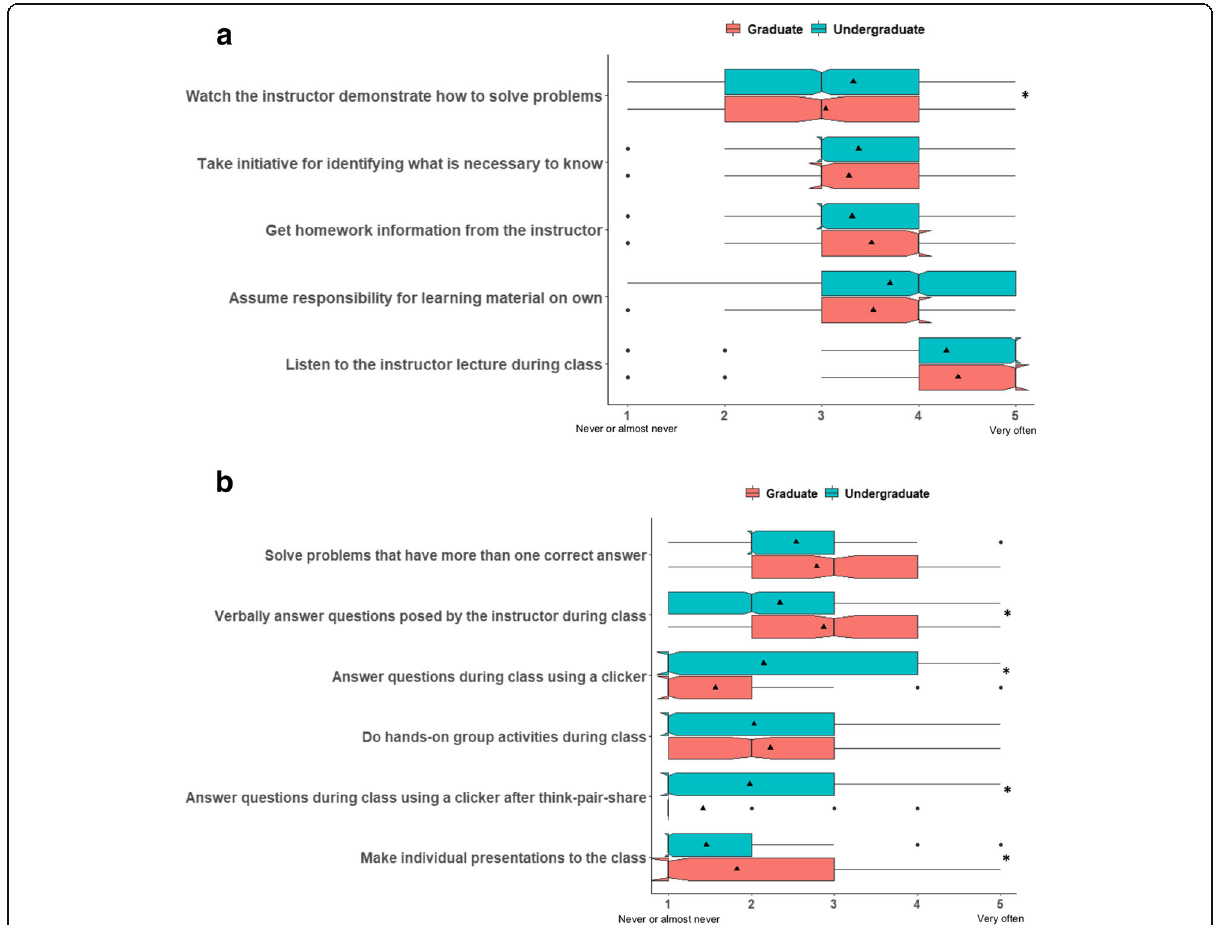
Fig. 1 Box and whisker plots of the most and least common instructional practices reported by graduate ( n = 161) and undergraduate ( n = 1113) students in STEM classrooms. a Most frequently experienced activities, and b Least frequently experienced activities. Triangles indicate mean values. *indicates p -values < 0.05. Activities displayed are the five most and least desired. A reported sixth activity in panel b reflects the ranking misalignment between graduate and undergraduate